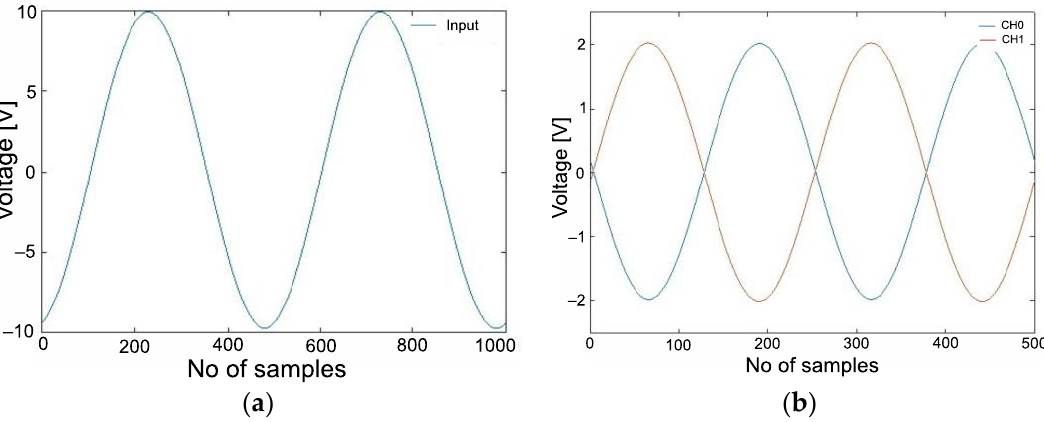
Figure 9. Verification of single-channel operation ( a ); verification of channel switching ( b ).